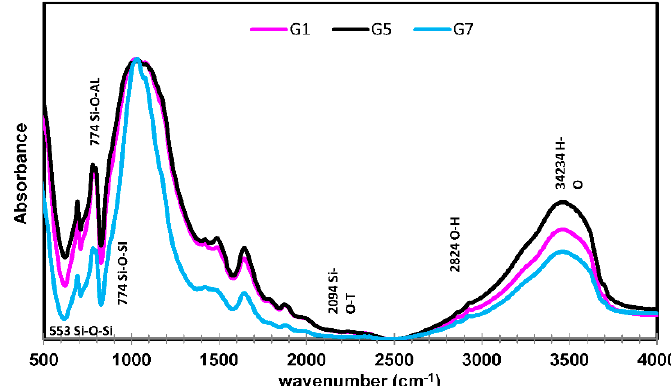
Figure 16. FTIR spectrum of UHPGC.